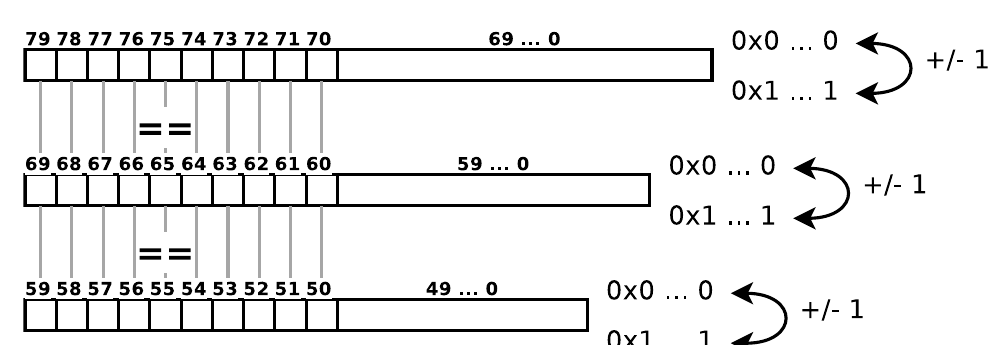
Figure 7: Simple adder design to evaluate fault attack